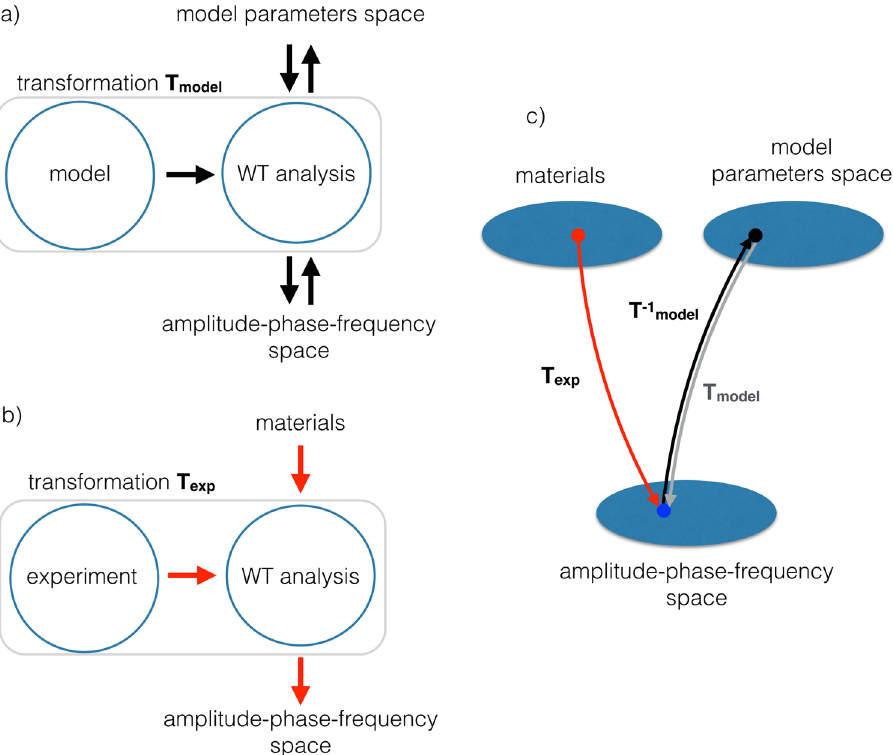
Figure 6. Flow charts of the main blocks of the analysis method. ( a ) representation of the mapping of the model parameters space into the amplitude-phase-frequency space. ( b ) Mapping of an experiment on a material to the amplitude-phase-frequency space. ( c ) Picture of how to associate a set of viscoelastic properties to a material using an experiment, see text for